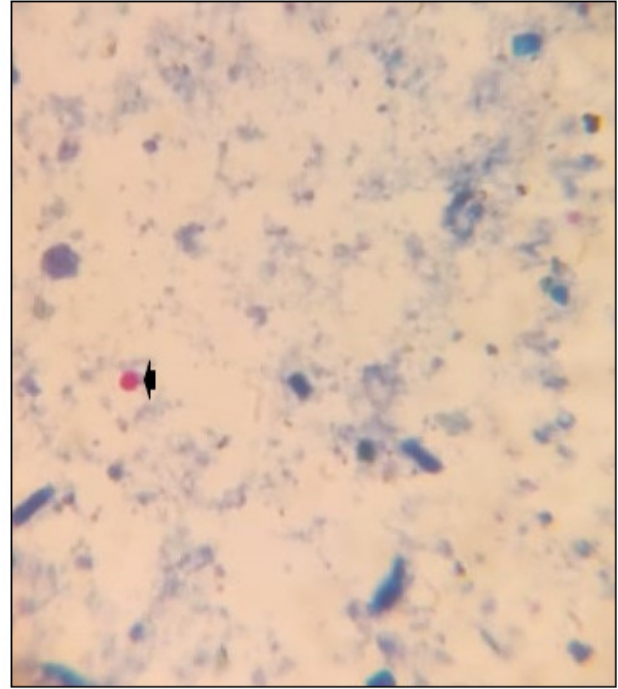
Figure 2. Cryptosporidium species oocyst (arrow head) of cattle, stained using the modified Ziehl-Neelsen staining technique (X1000)